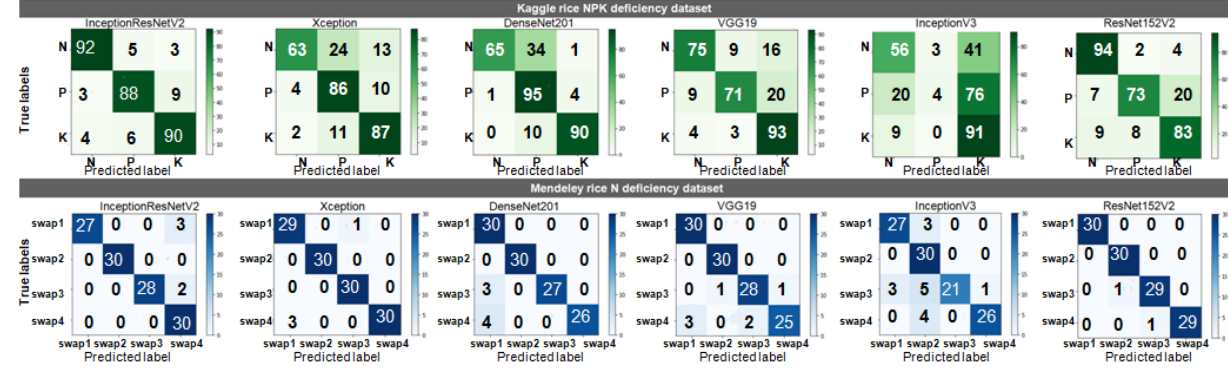
Figure 8. Confusion matrices of TL models for both datasets.